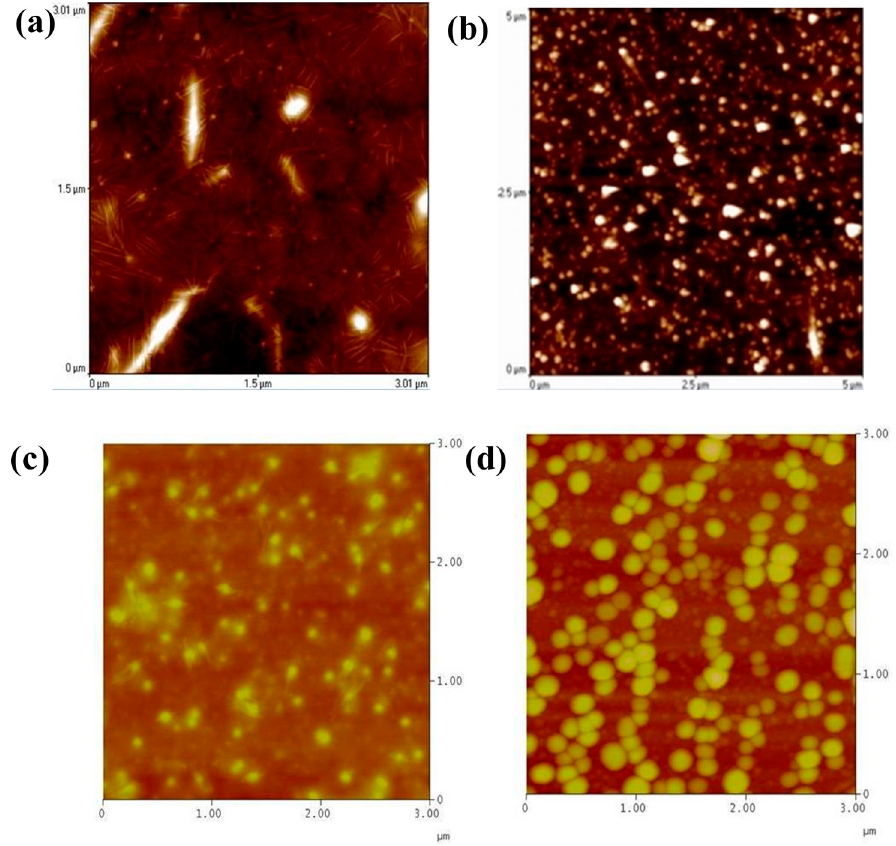
Figure 6. AFM images of POF 10 – b– PDPAEMA 197 aggregates in water at temperatures of ( a ) 30 °C, ( b ) 50 °C, ( c ) 60 °C, ( d ) 80 °C.